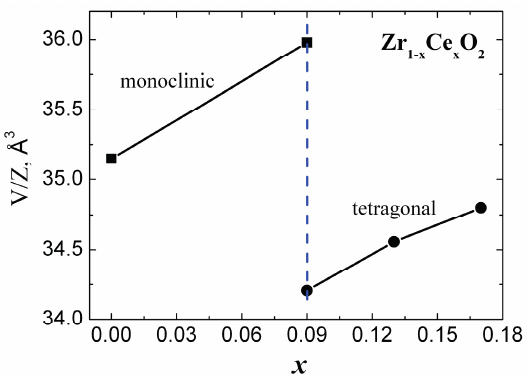
Figure 4. Variation of the unit cell volume of Zr 1- x Ce x O 2 vs. Ce concentration ( x ). Z—the number of molecules in the unit cell.